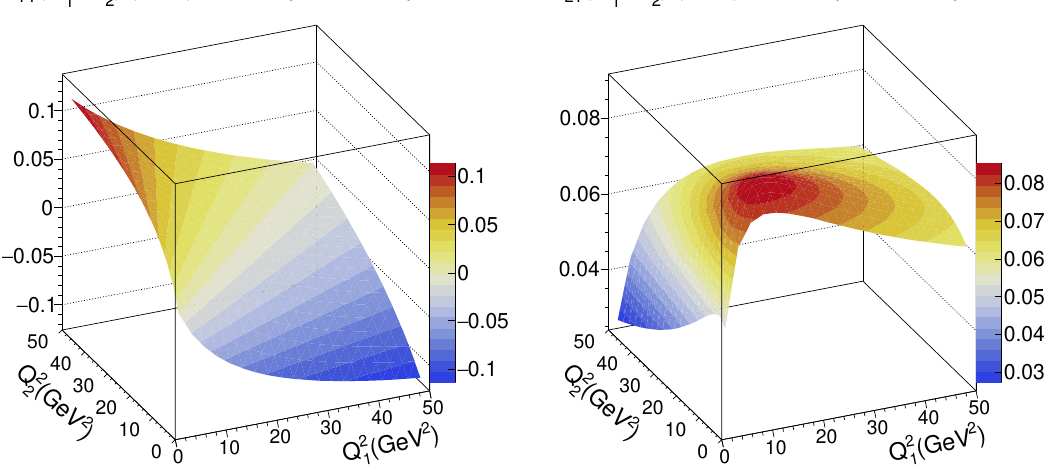
) on the two photon virtualities. , Q 2 ) and F LT ( Q 2 , Q 2 1 2 1 2